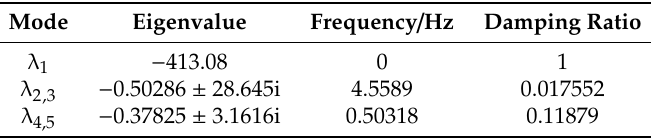
Table 2. Eigenvalues of the studied PV